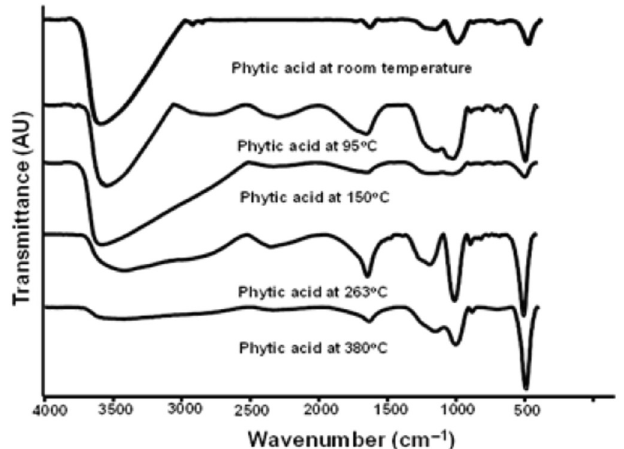
FIGURE 3 - FTIR spectra of phytic acid sample at room temperature and of the isolated products at 95, 150, 263 and 380